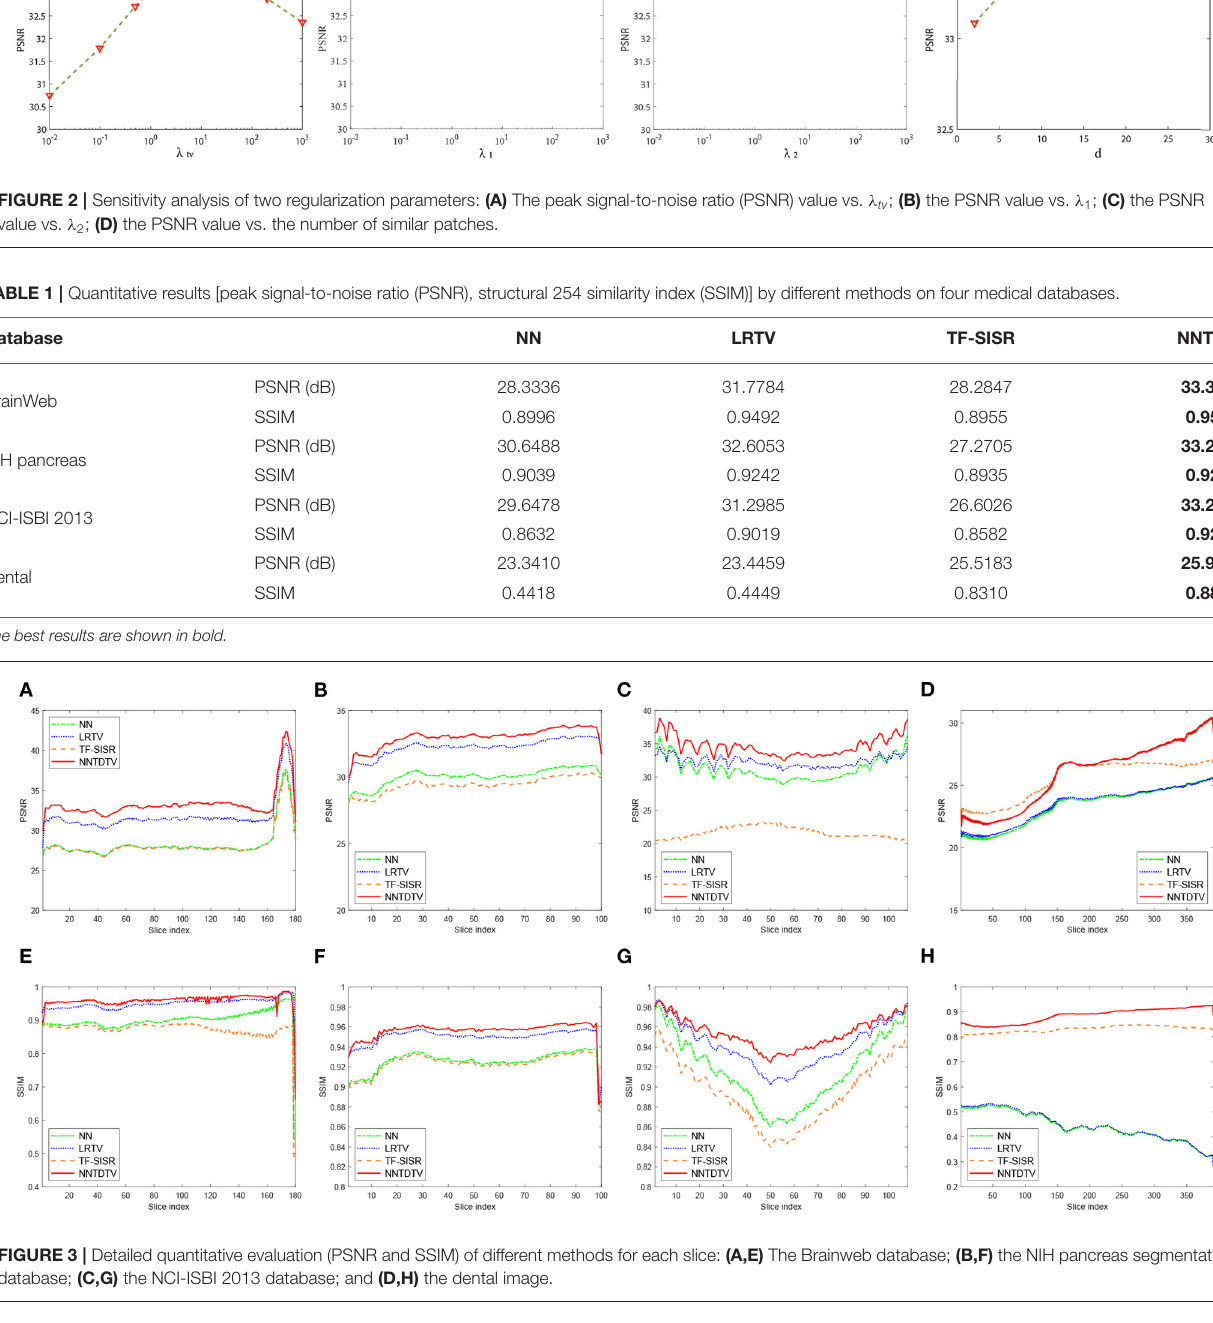
NIH pancreas segmentation database, respectively. Figure 7 shows two sets of results from the NCI-ISBI 2013